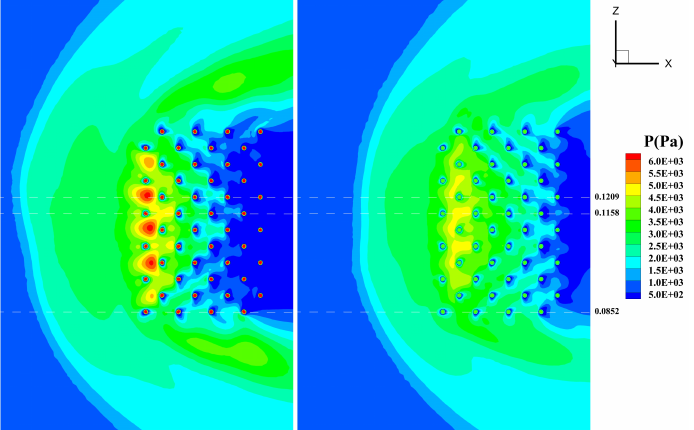
Figure 12. Detailed Lower Surface Pressure Distribution in Case 4 ( Left , C M = − 0.006832) and Case 5 ( Right , C M = 0.001821).